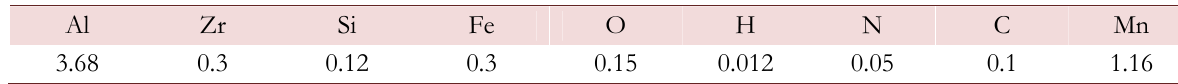
Table 1: The chemical composition of titanium alloy(%).